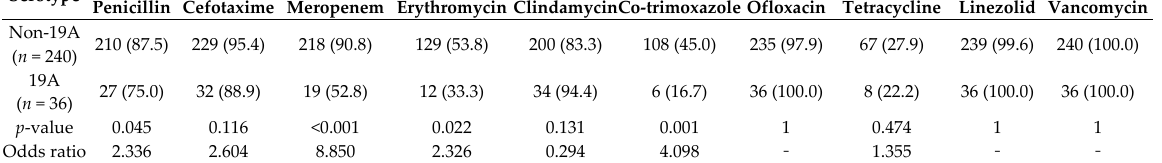
Figure 4. Antimicrobial susceptibilities of pneumococcus-causing IPD among serotype non-19A vs. 19A in central Thailand, 2012 – 2016. * statistically significant.